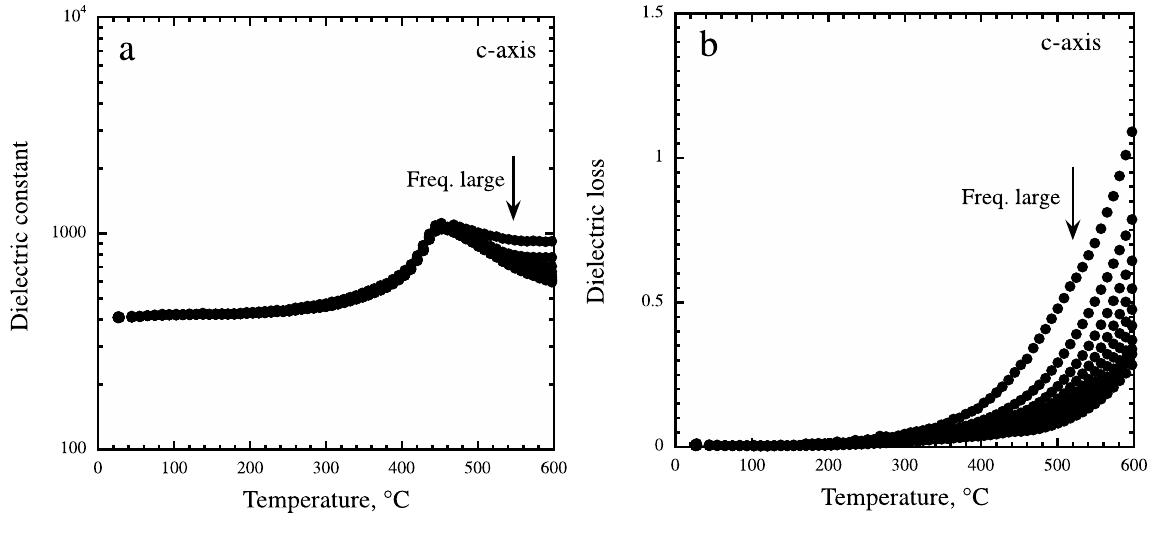
Figure 6. Temperature dependence of the dielectric constant of PKN crystals measured along the c -axis at 10 kHz with an applied electric voltage of 1 V, during the heating process, reprinted with permission from [33]. Copyright 2004 The Japan Society of Applied